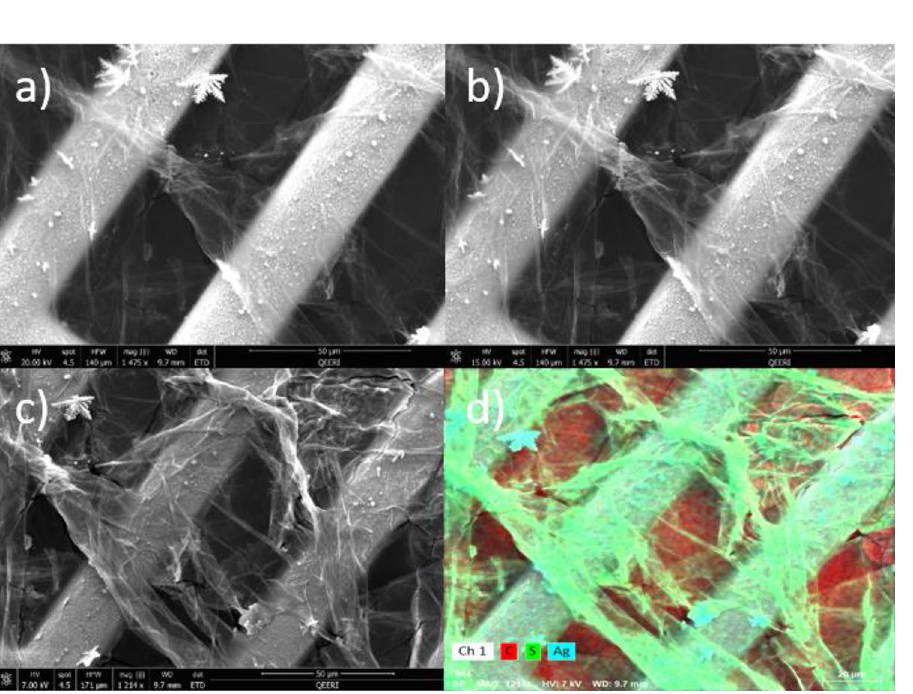
Figure 4. The morphology of the thin films produced using n-hexane. Scanning electron microscopy images taken at accelerating voltages ( a ) 20 kV ( b ) 15 kV and ( c ) 7 kV. ( d ) Elemental distribution of sulfur (green), carbon (red) and silver